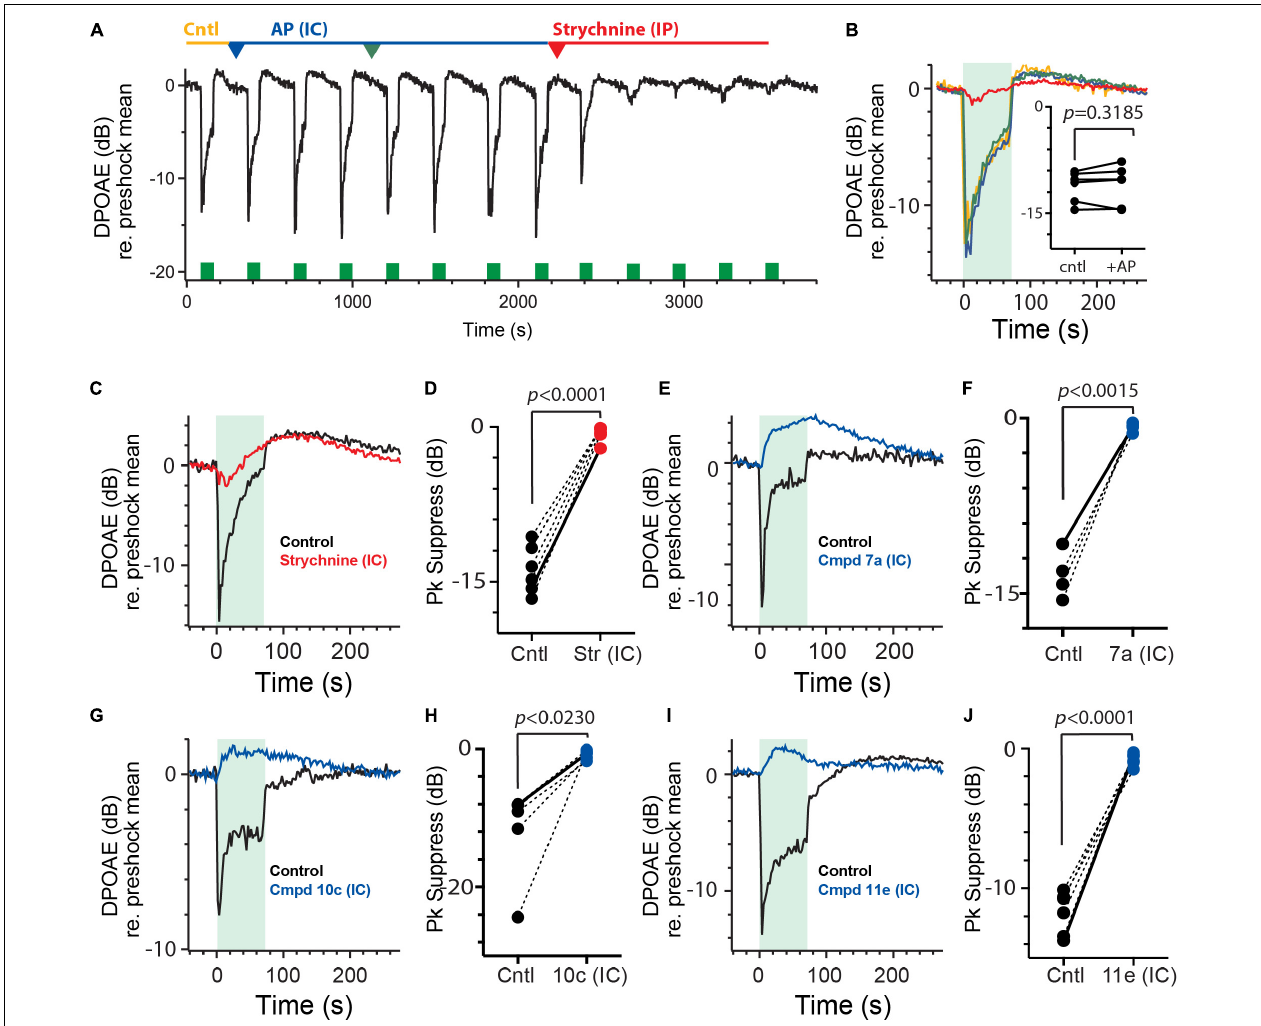
FIGURE 7 | Intracanal administration of charged α 9 α 10nAChR antagonists blocks efferent-mediated suppression of mice DPOAEs. (A) Continuous recording of mouse DPOAEs during midline stimulation of MOC efferent neurons (green bars, 200 shock/s for 70 s), before (Cntl) and after two IC injections of artificial perilymph (AP, 1–1.5 µ l each, blue and green arrowheads) and subsequent IP strychnine (6 mg/Kg, red arrowhead). (B) Mean responses, from (A) , showing the effect of midline efferent stimulation (70-s duration @ 200 shocks/s, green box) on DPOAE amplitude before (Cntl, yellow trace) and after two IC injections of artificial perilymph (AP, blue and green traces) and subsequent strychnine (red trace). Inset: peak values of efferent-mediated DPOAE suppression are plotted for multiple animals before (Cntl) and after the IC injection of AP (+AP). Indicated p -values were computed using a paired t -test. (C,E,G,I) Mean responses showing the effect of midline efferent stimulation (70-s duration @ 200 shocks/s, green box) on DPOAE amplitude before (Cntl, black trace) and after IC injection of strychnine (1.5 µ l @1.6 mM, red trace), Cmpd7a (1 µ l @ 5 mM, blue trace), Cmpd10c (3 µ l @ 2.5 mM, blue trace), or Cmpd11e (1.5 µ l @ 3 mM, blue trace), respectively. (D,F,H,J) Peak values of efferent-mediated DPOAE suppression (Pk Suppress) are plotted for multiple animals before (Cntl, black) and after IC injection of strychnine, Cmpd7a, Cmpd10c, or Cmpd11e (red or blue trace), respectively. Solid line shows values from corresponding traces in (C,E,G,I) . Indicated p -values were computed using a paired t -test. Binning in (A–C,E,G,I) is 2.3